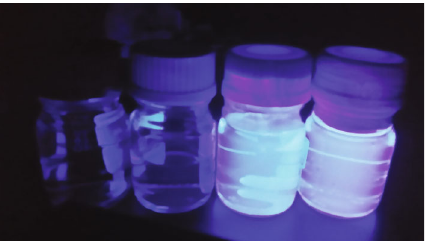
Figure 1: Light is emitted from samples illuminated by a 250nm wavelength UV lamp for eye inspection. From left to right, pure water (H O), 2-ethoxyethanol, NE3, and R sample. Pure water 2 and 2-ethoxyethanol do not emit light. Our main NE3 sample emits a relatively moderate amount of light compared with the R sample at the rightmost vial in the fi